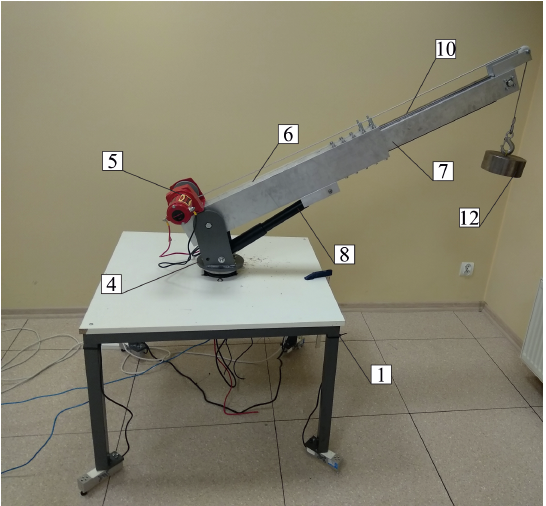
Figure 9. Laboratory truck crane: 1—chassis frame; 4—thrust bearing; 5—winch; 6; 7—aluminum profiles; 8—inclination angle actuator; 10—rail;